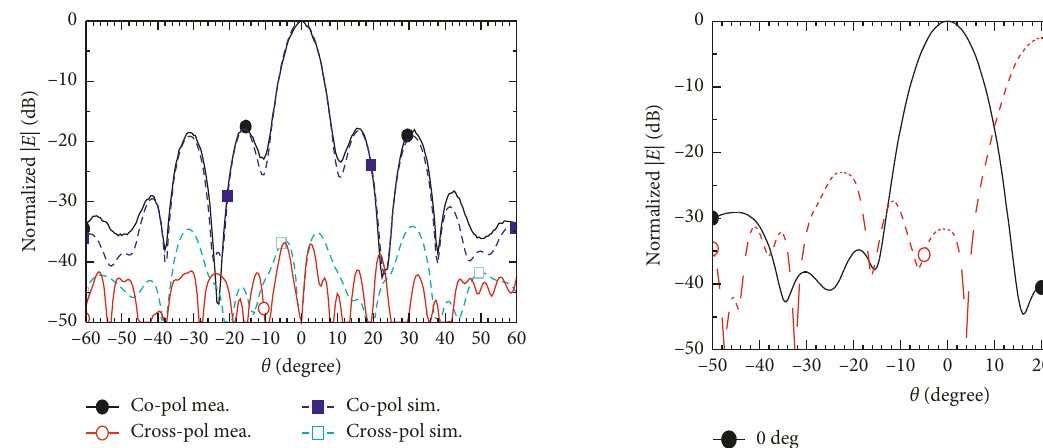
Figure 9: Measured and simulated xz -plane normalized patterns of the subarray in Mode I at 38GHz. Figure